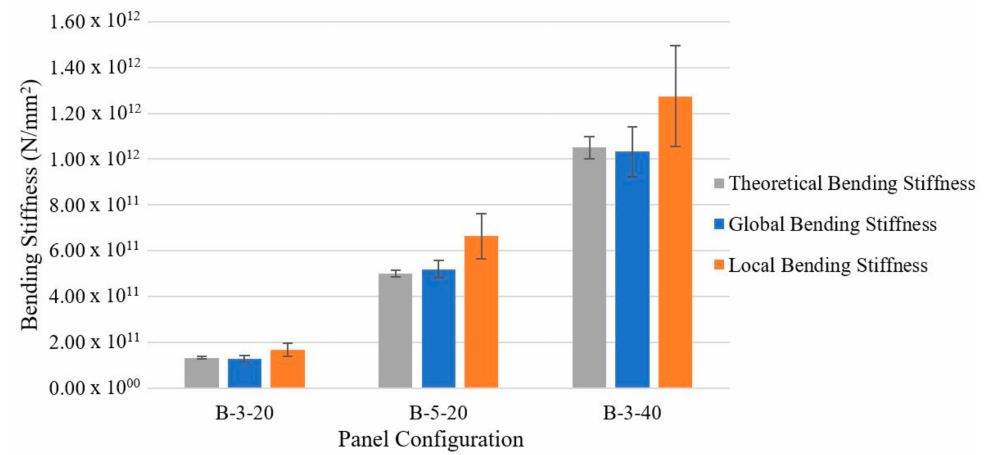
Figure 5. Mean bending stiffness results per meter width and the influence of panel configuration and depth.